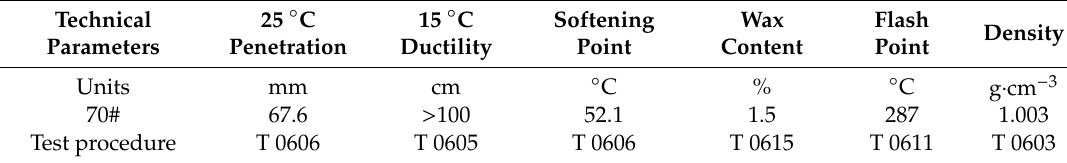
Table 1. Technical parameters of 70# asphalt.